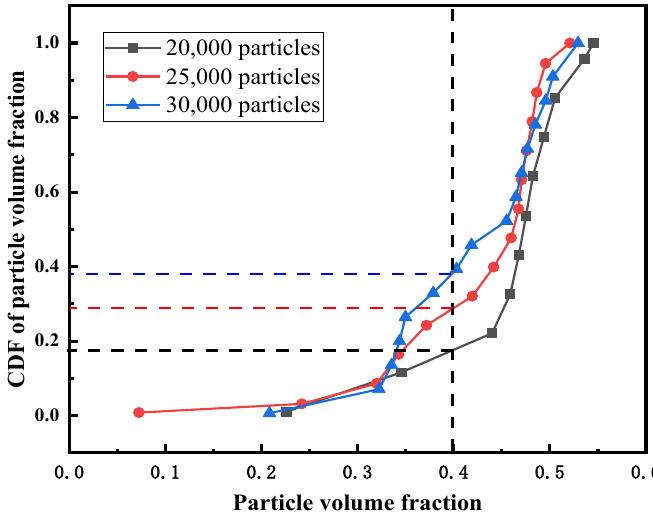
Figure 8. CDF of the particle volume fraction for different initial bed heights.